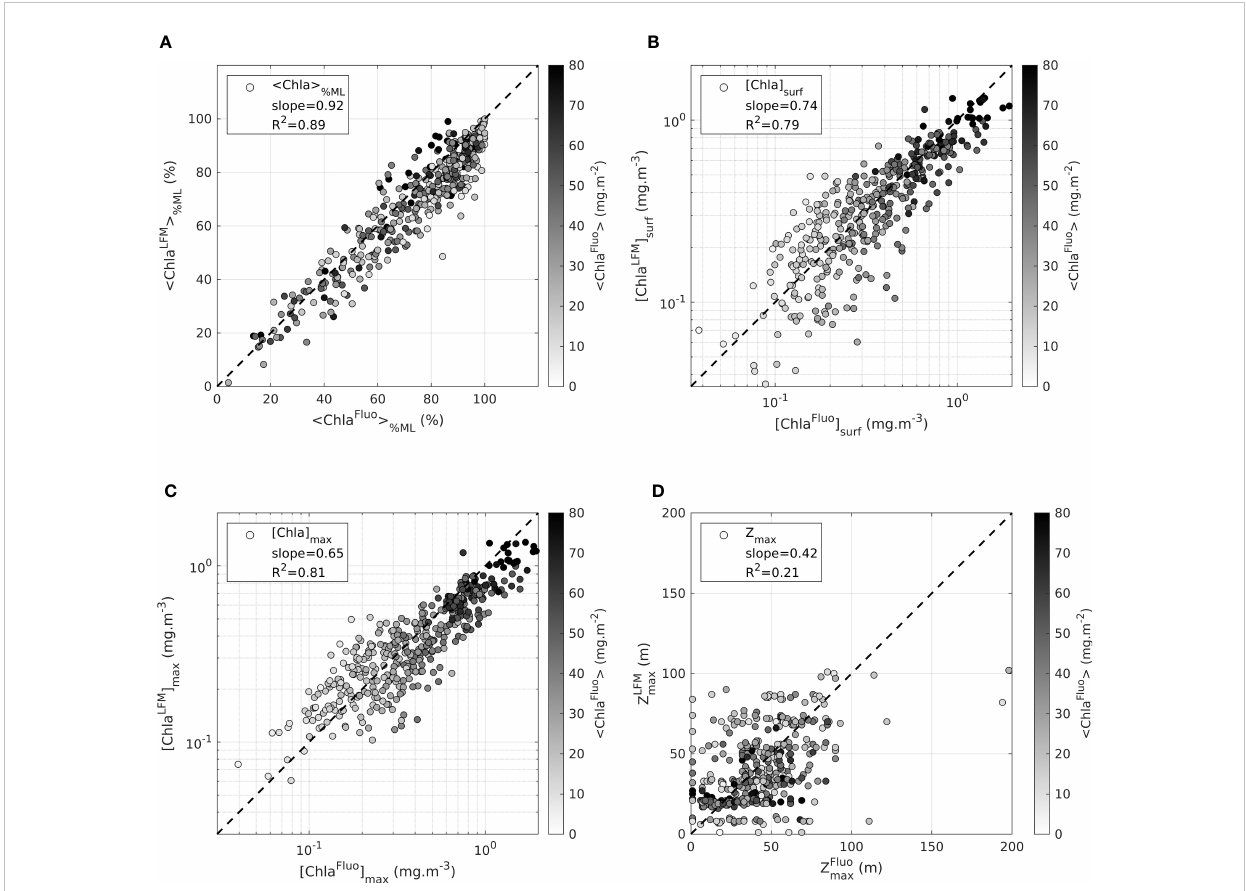
FIGURE 5 Assessment of the LFM performance on the validation sample. Values in the horizontal axis are metrics derived from the observations ([Chla fl uo ]). Values in the vertical axis are metrics derived from the predictions ([Chla LFM ]). The metrics examined to assess the performance of the LFM are (A) [Chla Fluo ] %ML , the percentage of Chla in the mixed layer (B) the surface value of [Chla], [Chla Fluo ] surf (C) the maximum value of [Chla], [Chla Fluo ] max and (D) Z Fluo max , the depth of the maximum value of [Chla]. The dashed black lines in each plot represent the 1:1 reference line. The metrics (R 2 , slope) associated with the linear regression performed between model predictions and observations are indicated in each